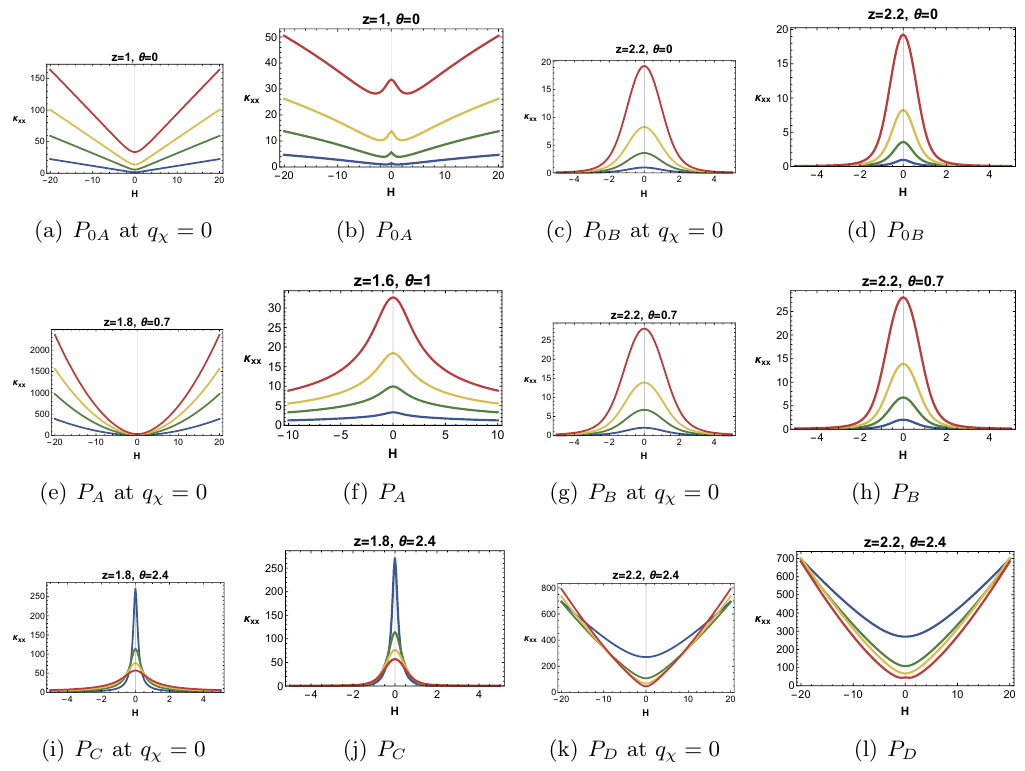
Figure 10 . Temperature evolution for (cid:20) xx ( H ) for di(cid:11)erent ( z; (cid:18) ). Each curve corresponds to T = 0 : 04 ; 0 : 1 ; 0 : 16 ; 0 : 24 for blue, green, yellow and red respectively. We used q (cid:31) = 0 : 7 for all non-zero q (cid:31)